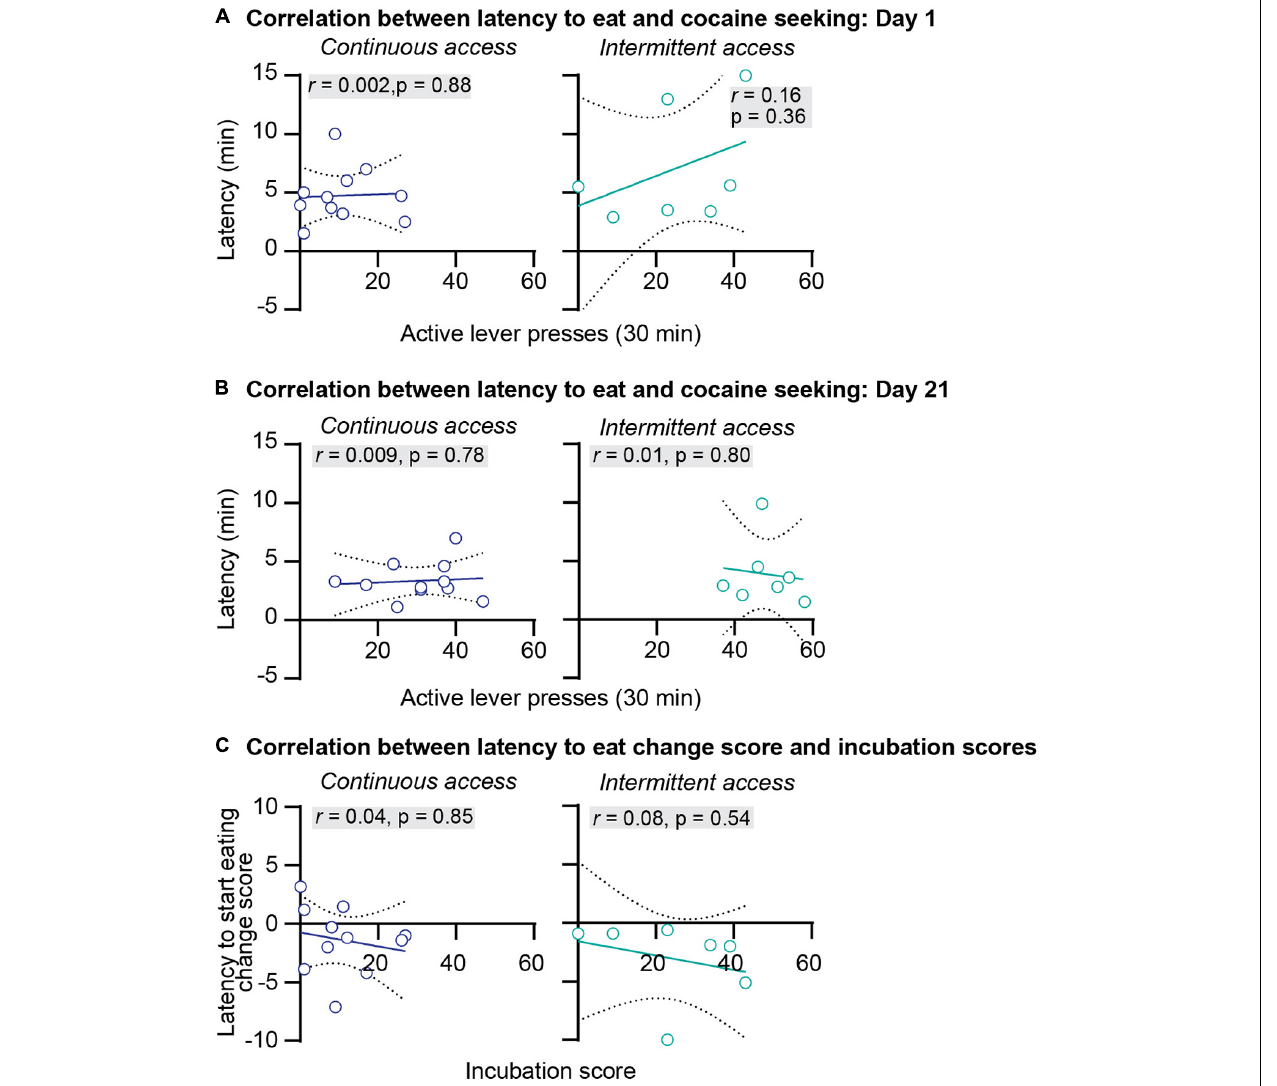
FIGURE 4 | Correlations between the latency to start eating and incubation of cocaine craving. (A) Correlations between the latency to start eating in minutes and the number of active lever press during relapse test on abstinence day 1 after continuous (left) and intermittent (right) self-administration (continuous access n = 11, intermittent access n = 7). (B) Correlations between the latency to start eating in minutes and the number of active lever press during relapse test on abstinence day 21 after continuous (left) and intermittent (right) self-administration (continuous access n = 11, intermittent access n = 7). (C) Correlations between the latency to start eating change score (minutes to start eating on abstinence day 21 minus minutes to start eating on abstinence day 1) with the incubation score (active lever presses on abstinence day 21 minus active lever presses on day 1) after continuous (left) and intermittent (right) cocaine self-administration (continuous access n = 11, intermittent access n =